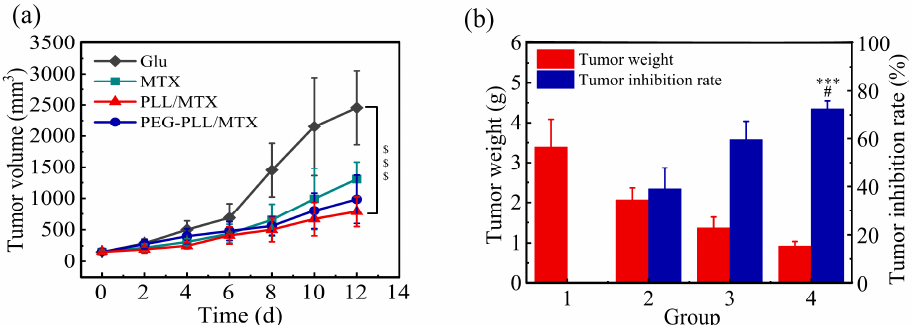
Figure 7. Tumor volume curves of four groups during the 12-day administration ( a ). Tumor weight and the related inhibition rate ( b ) (n = 6) (Group a: glucose solution; group b: MTX injection; group c: PEG-PLL/MTX NPs; group d: PLL/MTX NPs). $$$ p < 0.001 vs. glucose solution; *** p < 0.001 vs. MTX injection; # p < 0.05 vs. PEG-PLL/MTX NPs.